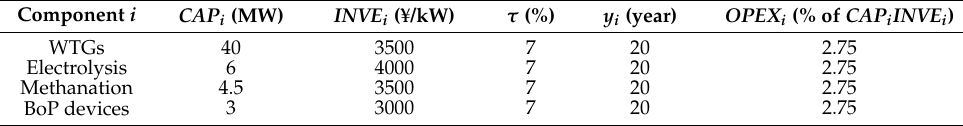
Table 2. Economic parameters for WTGs, electrolysis, methanation, and BoP devices in the wind farm.